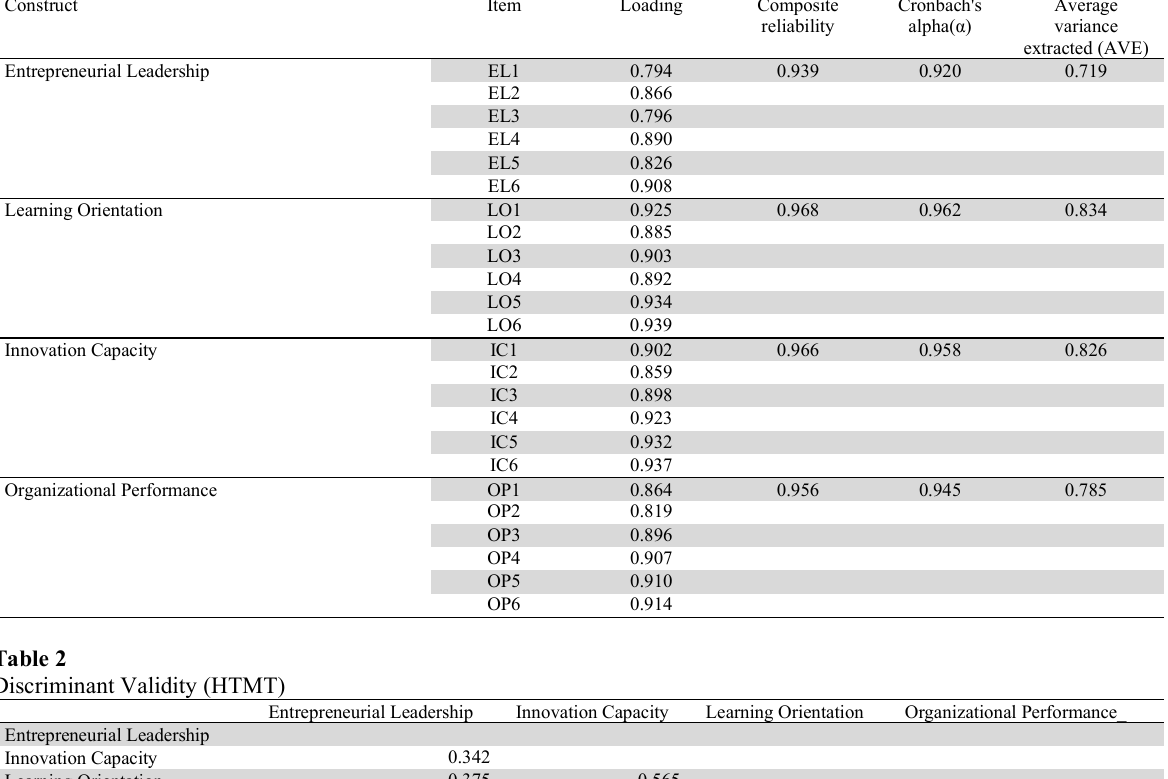
The Outer Loadings, Reliability and Validity Measures